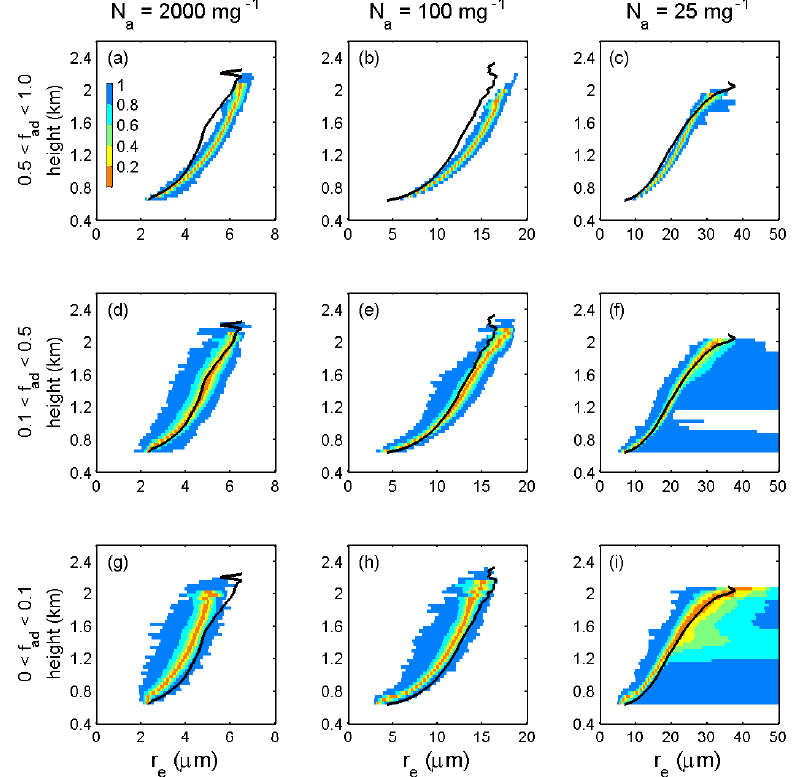
Fig. 7. r e profiles from different cloud samples over the last 4h of simulation for the three cases. (a, b, c) Sub-adiabatic regime (0 . 5 < f ad < 1 . 0); (d, e, f) strongly diluted regime (0 . 1 < f ad < 0 . 5); (g, h, i) very strongly diluted regime (0 < f ad < 0 . 1). Black lines are the 50th percentiles of the r e from all cloud samples for reference (same as in Fig. 1). Color scale is the same as Fig. 1.